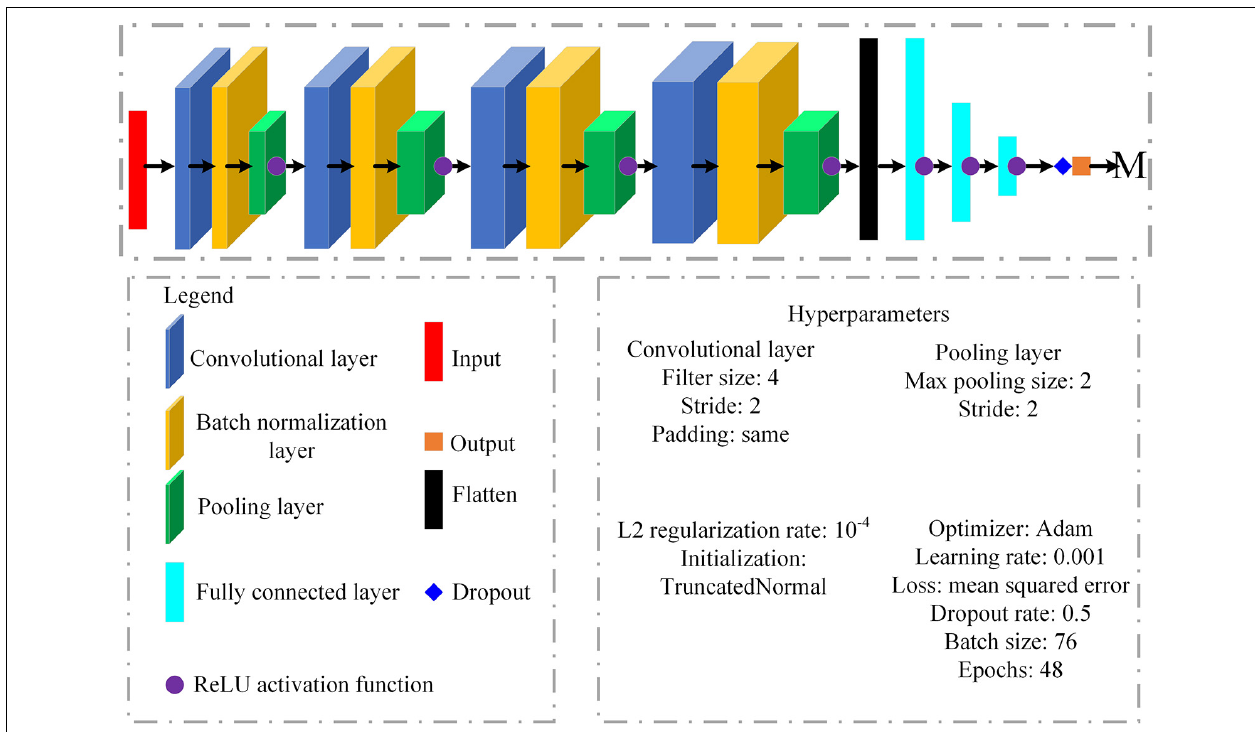
FIGURE 3 | The architecture of the DCNN-M model. Twelve parameters related to the frequency, amplitude, and energy extracted from the 3-s period after P-wave arrival are used as the inputs of the DCNN-M model. The hyperparameters of the DCNN-M model include the filter size, stride, padding, initialization, optimizer, learning rate, regularization, and dropout,